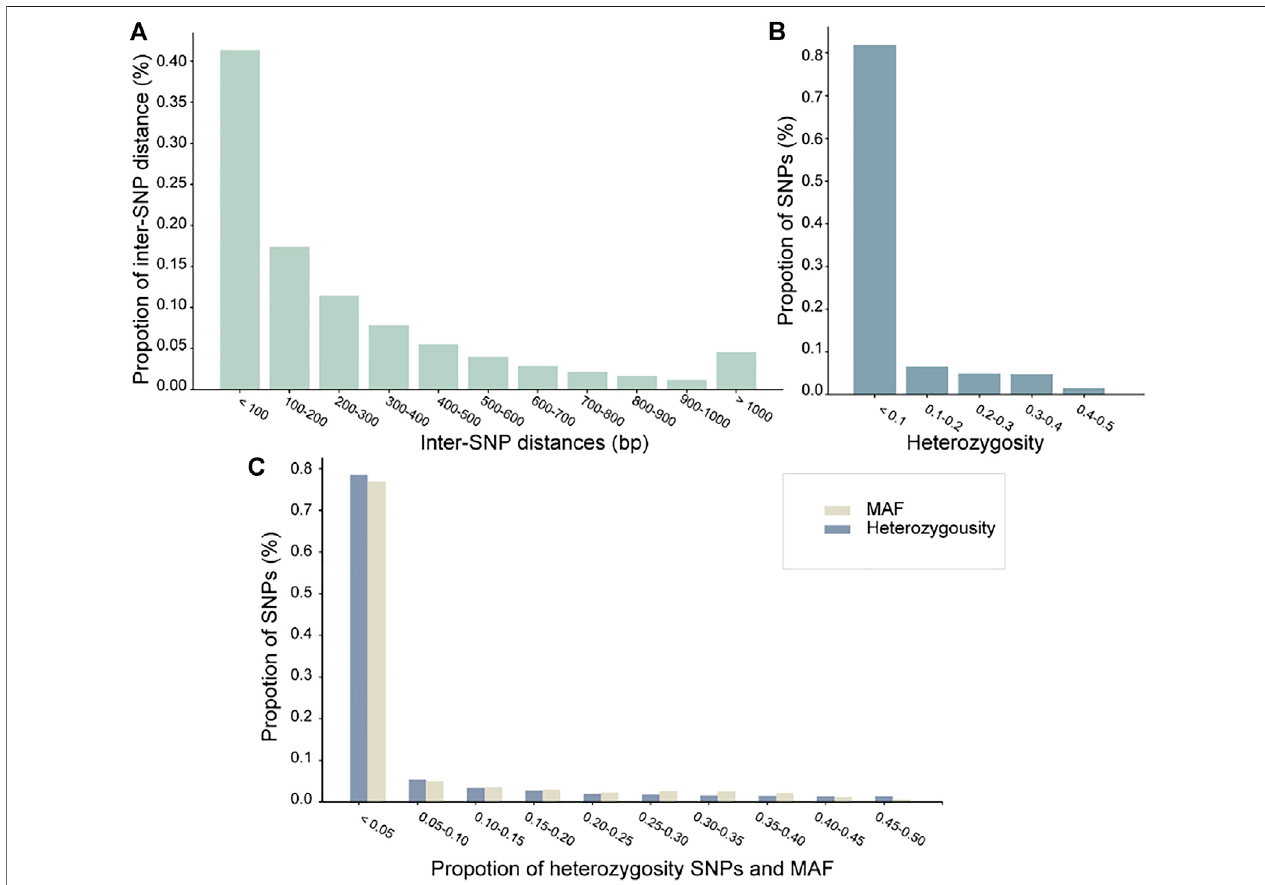
FIGURE2|(A-C) arebargraphstovisualizeSNPstatisticsinthedonkeyhaplotypedataset.Thehorizontalaxisrepresentsthedistancesinter-SNPs,distributionof heterozygosity SNPs, and comparison of MAF and heterozygosity SNPs. The vertical axis represents the ratio of SNP/inter-SNPs (%).